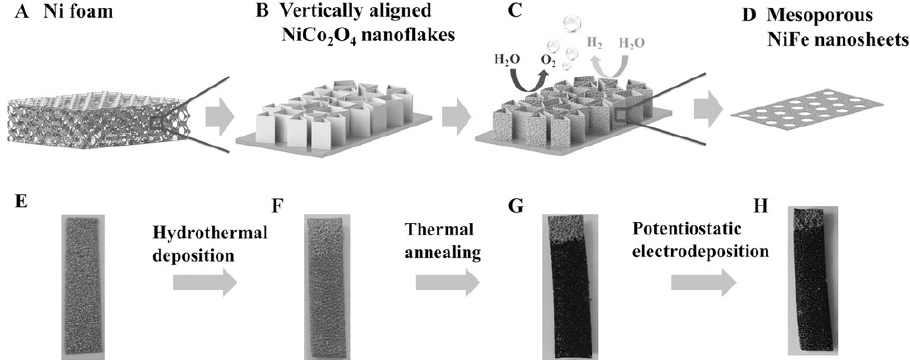
Figure 19. Formation process of porous NiFe/NiCo 2 O 4 /NF composite electrodes: Scheme ( A – D ) and corresponding photos ( E – H ). Reproduced from [53], with permission from John Wiley and Sons, copyright 2016.